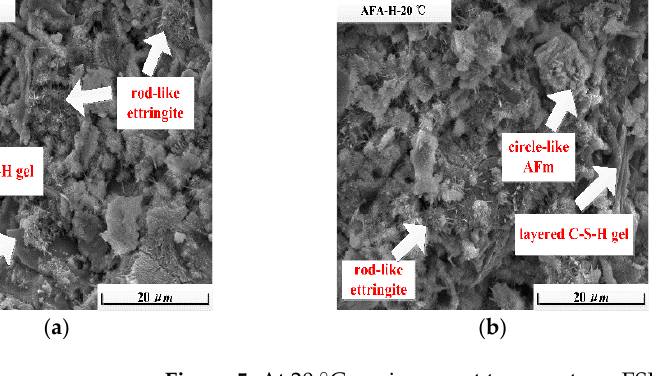
Figure 5. At 20 °C environment temperature, ESEM images of cement paste with reference one ( a ), alkali-free accelerators without fluoride ( b ), and with fluoride ( c ) at 24 h of hydration.